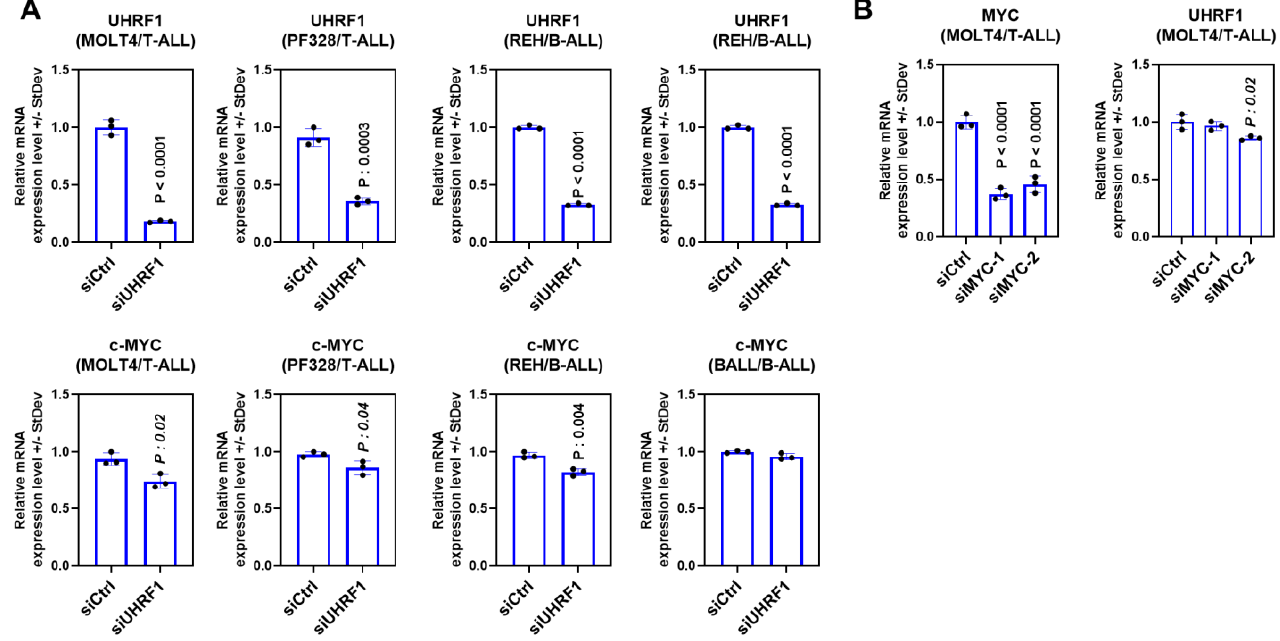
Figure A3. ( A ) mRNA expression of UHRF1 and c-Myc following a siRNA-mediated knockdown of UHRF1 in the T-ALL cell lines MOLT4 and PF328 and the B-ALL cell lines REH and BALL. The statistical significance was determined using a two-sided Student t-test in comparison with the siControl. ( B ) The mRNA expression of UHRF1 following a siRNA-mediated knockdown of c-Myc in the T-ALL cell line MOLT4.